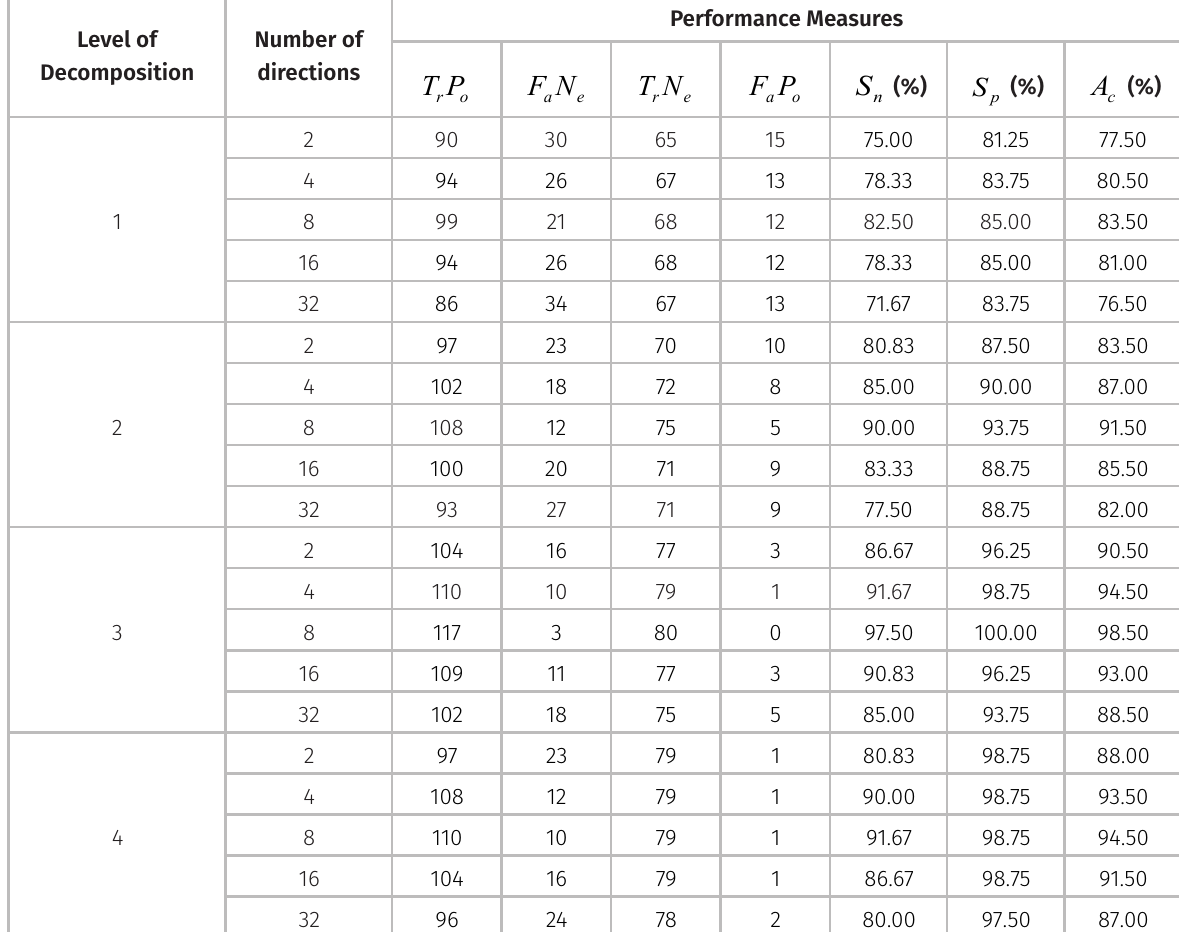
Table II. SVM-RBF Classifier performance for NoAb phase.